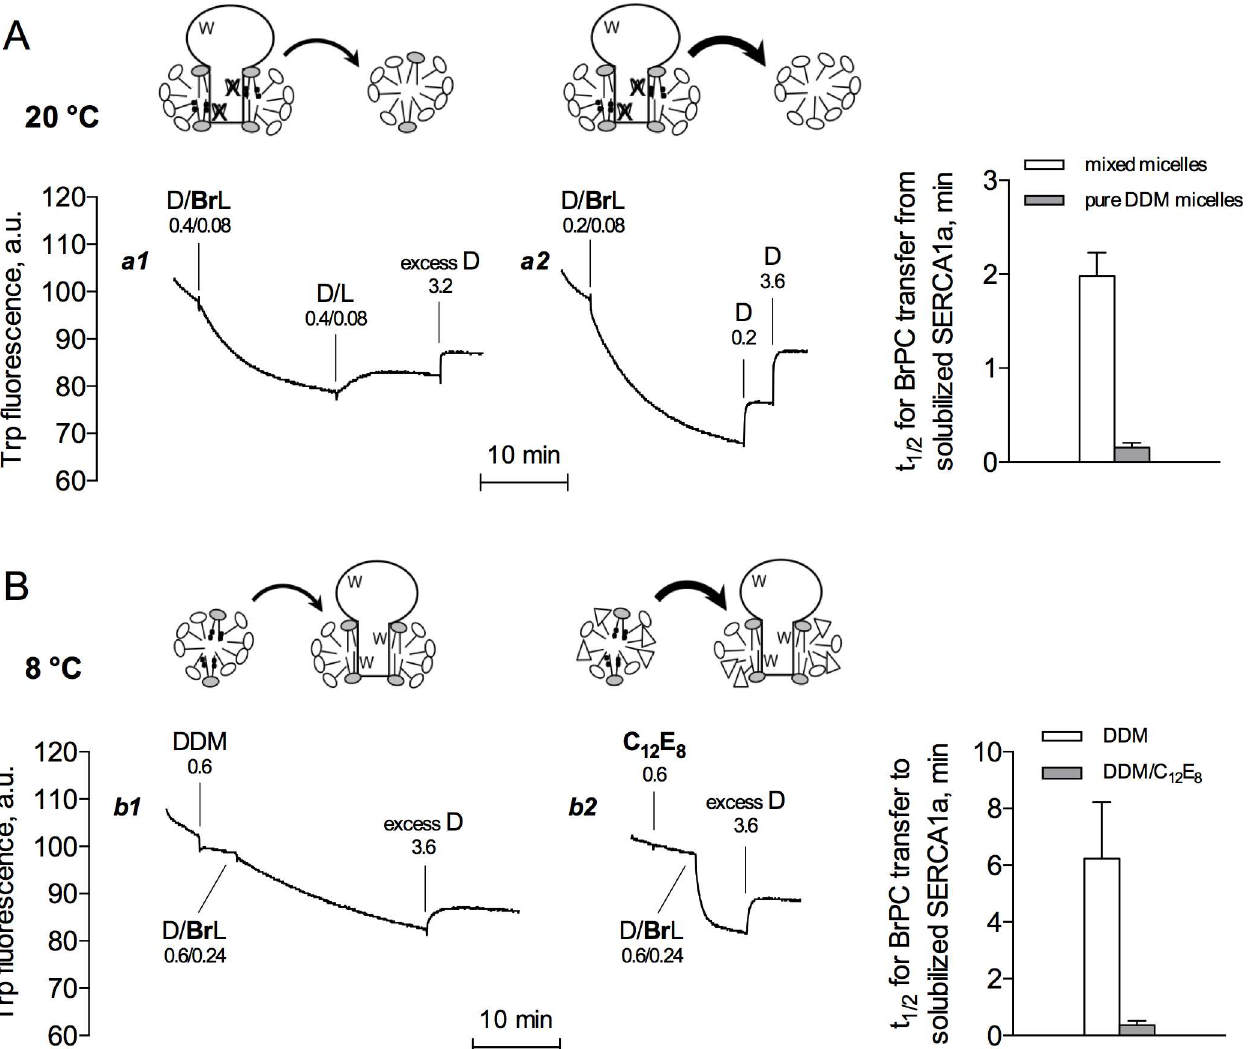
Fig 3. BrPC transfer is greatly accelerated during asymmetrical transfer, as well as in the additional presenceof C 12 E 8 . (A) Temperature was 20˚C and buffer A was used, as for Fig 1. Each trace corresponds to one experiment representative of three independent experiments. Trace a1 illustrates an experiment similar to that previously shown as Trace a2 of Fig 1 (identicalassay conditions but independentexperiments). Trace a2 shows a related experiment, where brominatedlipid was first addedat a higherbromolipidto detergentratio, as indicated, while subsequently only DDM was added, in two steps, to monitor the kinetics of fluorescence recovery under ‘asymmetrical’ conditions. The histograms on the right represent half-times for BrPC transfer from solubilized SERCA1ato either mixed egg PC/DDM micelles(open bars, as in Trace a1 ) or pure DDM micelles(grey bars, as in Trace a2 ). Data are presentedas the mean ± S.D. (error bars) of three independentexperiments. (B) Temperature was here 8˚C and buffer B was used. Each trace corresponds to one experimentrepresentativeof three independentexperiments. Trace b1 illustrates an experimentsimilar to that previouslyshownas Trace a6 of Fig 2 (identicalassay conditions but independent experiment). Trace b2 shows a related experiment, where membranes were initiallysolubilized with C 12 E 8 at 0.6 mg/mL instead of DDM. Then BrPC in DDM was added (at 0.24 mg/mL and 0.6 mg/mL, respectively), as for the left trace. Phospholipid exchangetherefore now took place in the presenceof 0.24 mg/mL BrPC, 0.6 mg/mL DDM and 0.6 mg/mL C 12 E 8 insteadof 0.24 mg/mL BrPC and 1.2 mg/mL DDM. Since detergent itself is thought to exchangerapidly, DDM and C 12 E 8 presumably soon exchangedwith each other, hence the cartoon on the right representing a mixed ternary micelle and a protein belt with both detergents. In this cartoon, the polar headgroupof C 12 E 8 is representedas triangles. At the end, excess DDM was added at 3.6 mg/ ml, so that total DDM and C 12 E 8 concentrations were 4.2 and 0.6 mg/mL, respectively.Numbers indicate the concentrations of detergentand lipid added to the cuvette at each step, in mg/mL. The histograms on the right represent half-times for BrPC transfer to solubilizedSERCA1acalculated from traces of the same panel. Data are presentedas the mean ± S.D. (error bars) of three independent